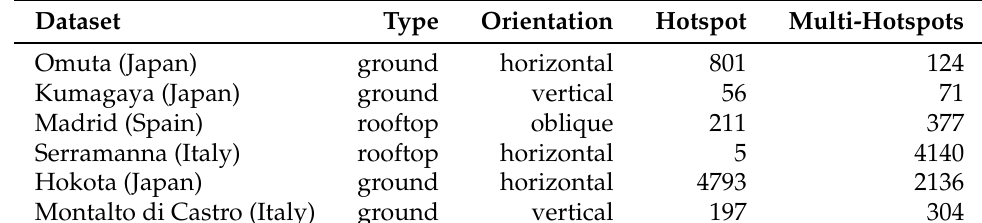
Table 1. The specifications of the different datasets used for training and validation.